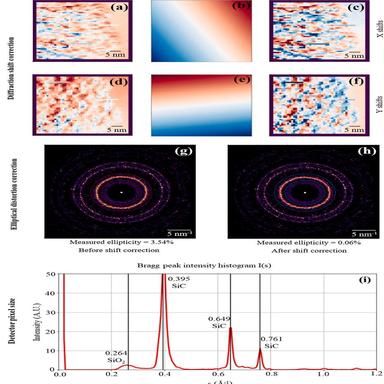
Calibration: (a-f) diffraction shift correction, (g-h) elliptical distortion correction, and (i) pixel size calibration.